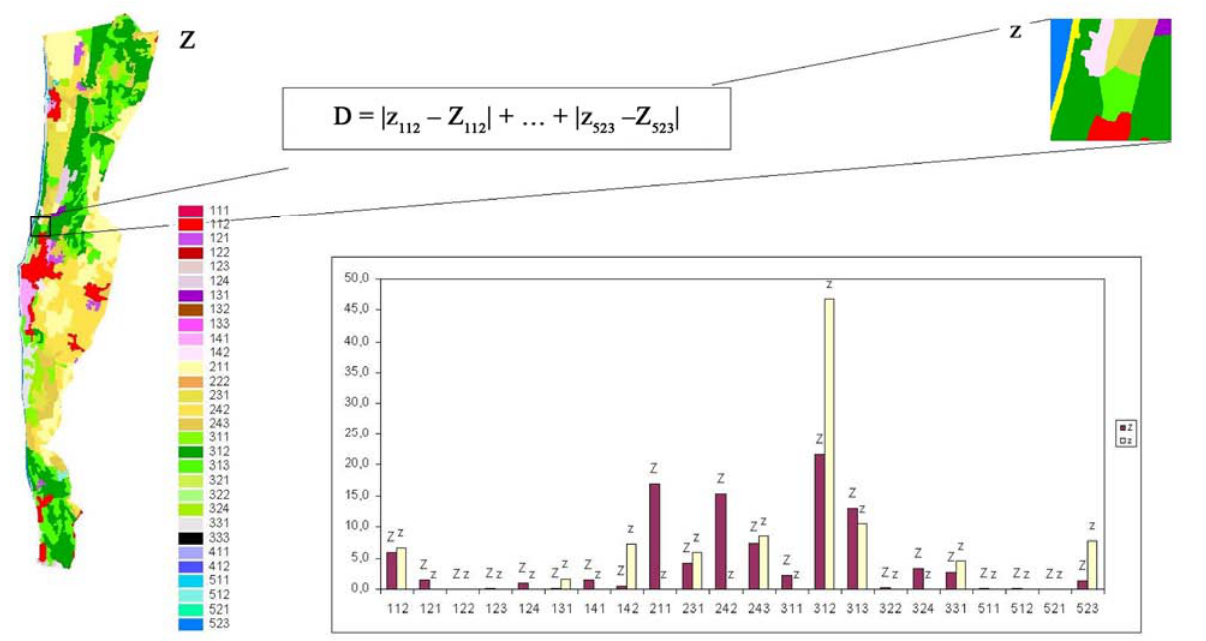
Fig. 2. Calculation procedure for the index of remoteness of structures between landscape type (marked by Z ) and pseudo sample (marked by z ). The total sum of all the differences between z and Z of each land cover type (112 to 523),